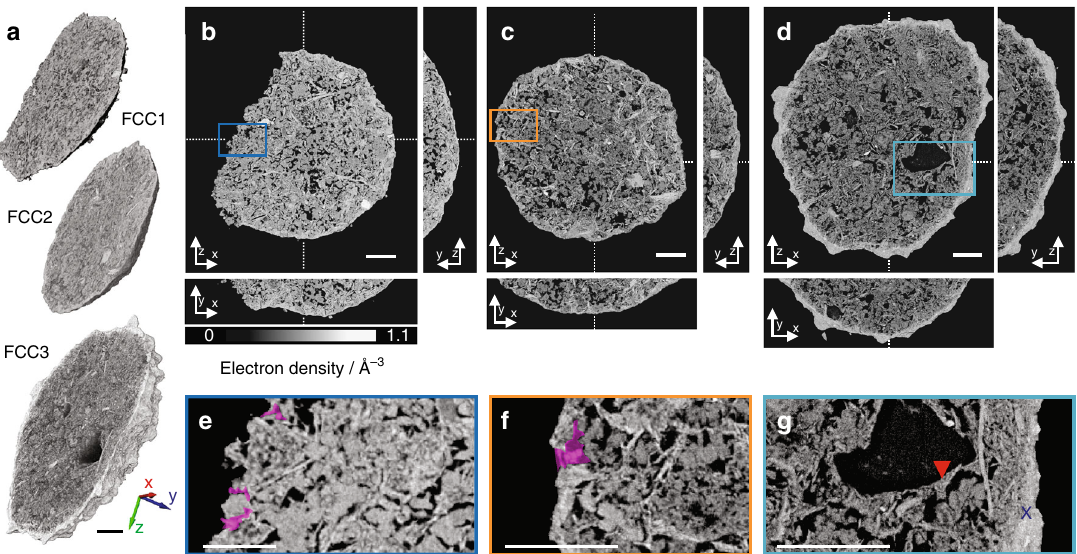
Fig. 2 Ptychographic image reconstructions. a Volume reconstructions of FCC1, FCC2, and FCC3. Orthoslices through the retrieved electron density maps are shown in b – d , respectively. Presented are bottom up ( z – x ) and orthogonal views ( y – z , y – x ). Cutting planes are represented by dotted lines . Shown in e – g are enlarged versions of selected areas. Common to all sub fi gures is the linear grey scale for the electron density. Selected diffusion highways (-) are highlighted in pink , hydrocarbon deposits by a red triangle , and the ASA shell by a blue cross . Voxel size is about (20 nm) 3 . Scale bars are 5 µ